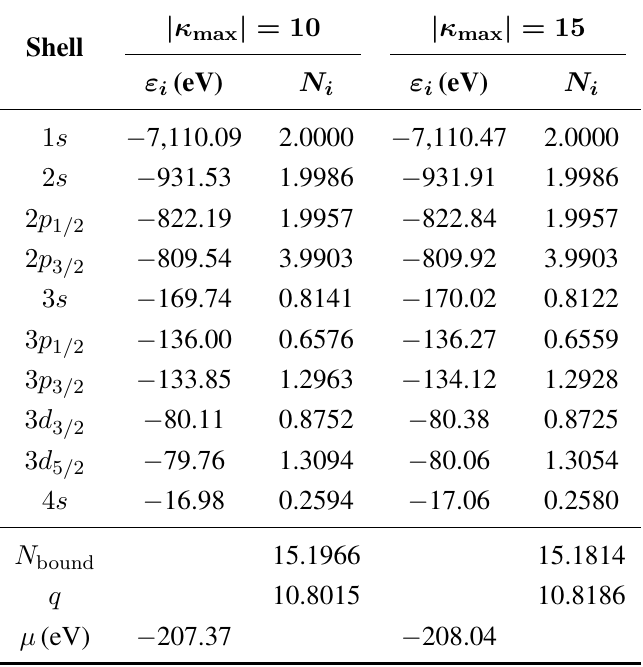
Table 5. Binding energies ε the charge q and the chemical potential µ calculated for various | κ k T = 100 eV and R β